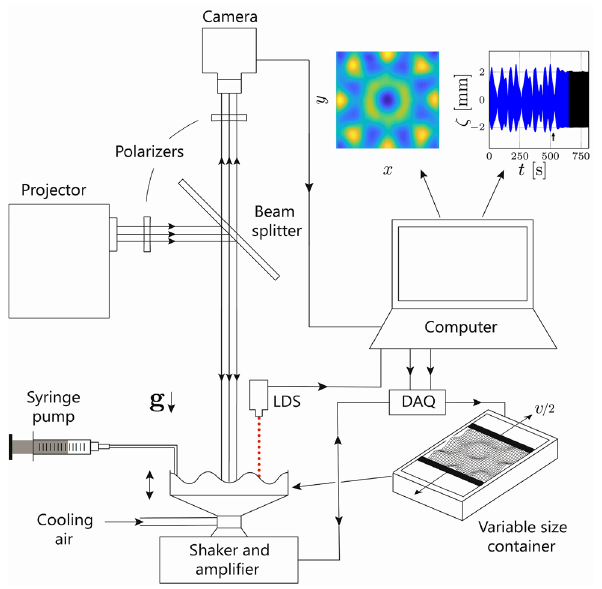
Figure 10. Experimental setup. The Faraday waves assembly with variable size container is mounted on the shaker which is driven using the amplifier and controlled through the data acquisition card (DAQ). The surface wave amplitude is measured using the laser displacement sensor (LDS). The camera, projector, beam splitter, and polarizers form the optical part required to visualize the Faraday